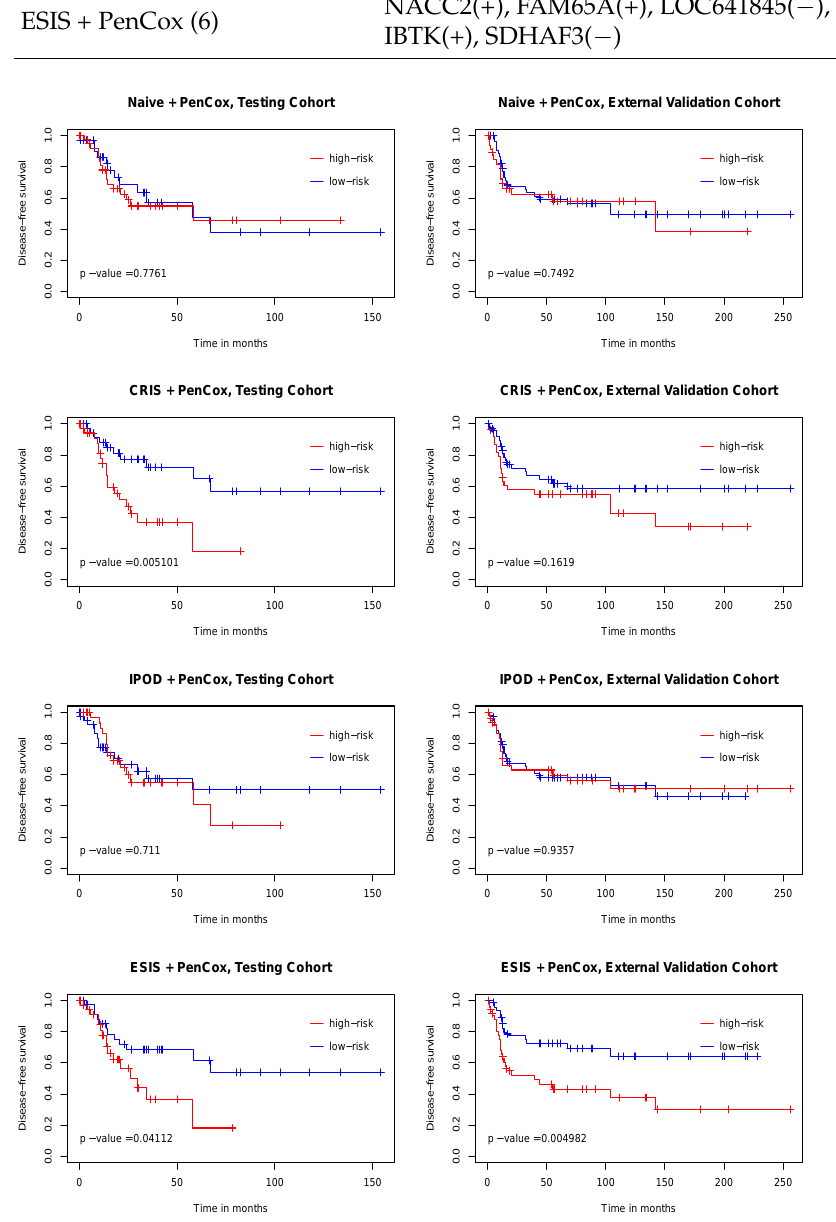
Figure 3. Kaplan–Meier curves of disease-free survival for test (TCGA) and validation (GEO) cohorts varying with the risk level determined by the four competing models. p -values were obtained from the log-rank tests contrasting the two risk